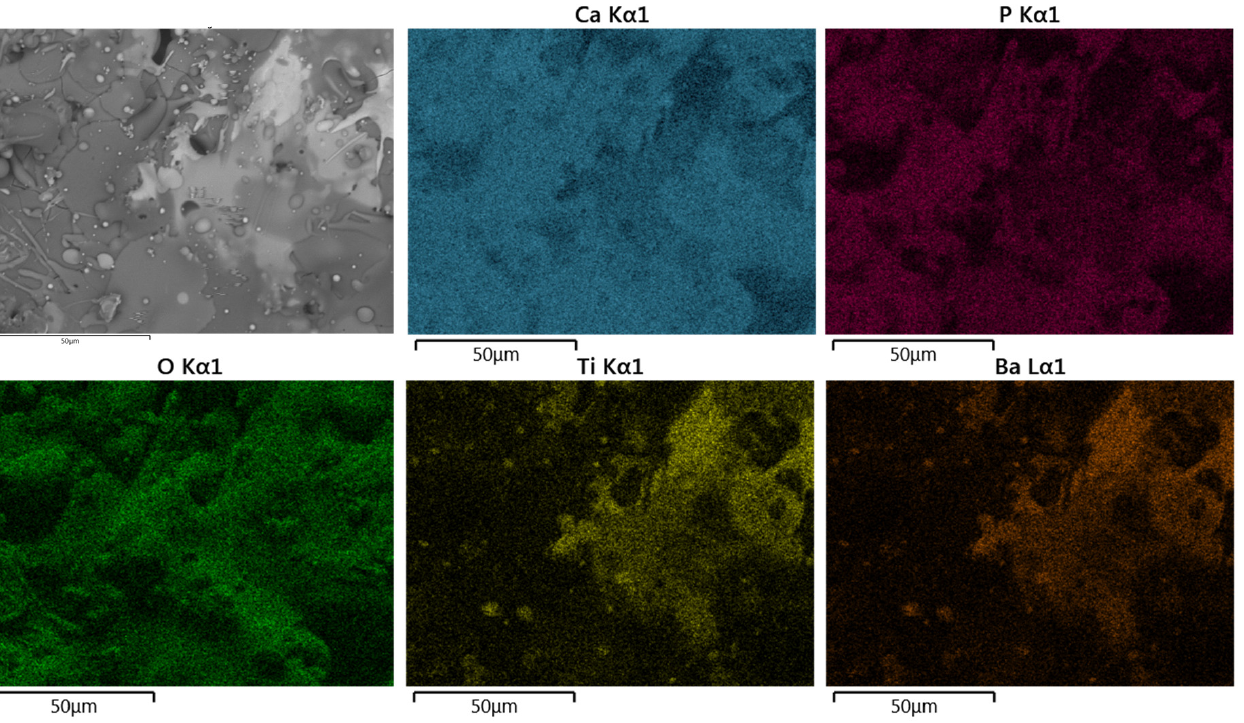
Figure 9. Typical SEM-BSE image in superficial section and corresponding EDS elemental mapping of Ca, P, O, Ti, and Ba of HA30BT coating performed with HEBM powders.